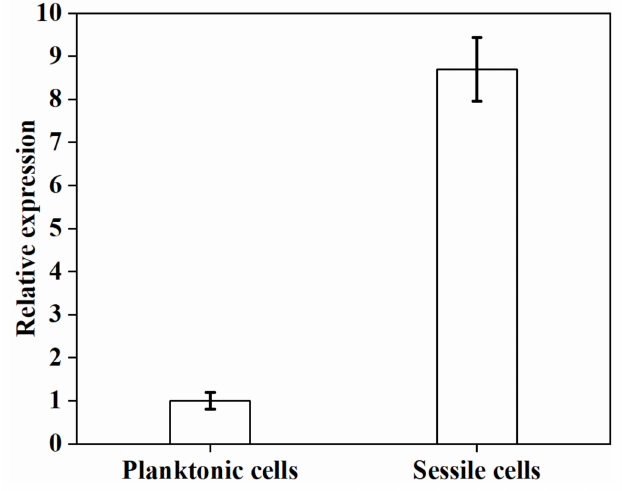
Figure 11. The expression level of luxS for sessile cells compared to planktonic